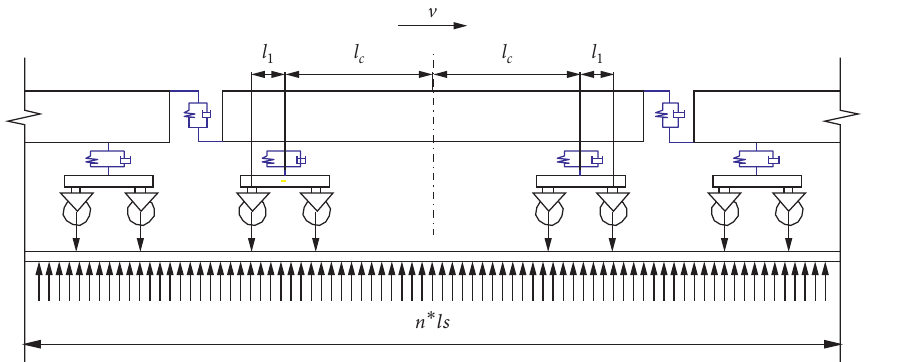
Figure 2: Schematic of the interaction force between the vehicle and the sleeper (2 l sleeper space; n , number of sleepers).